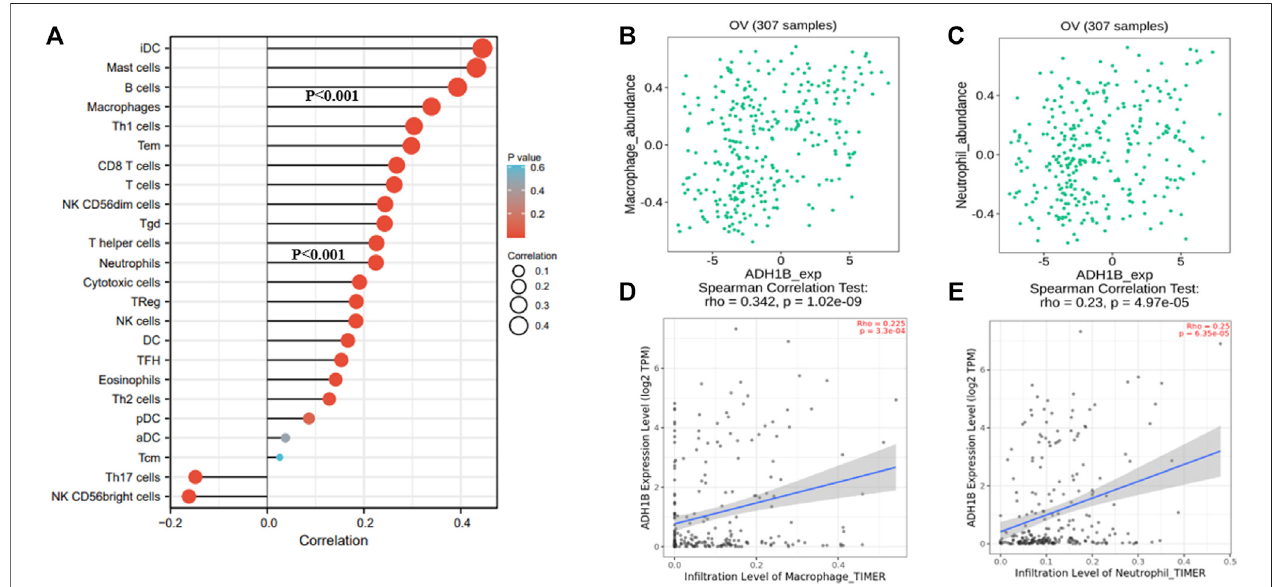
FIGURE 5 | The relationship between ADH1B and immune in fi ltration. (A) 24 kinds of immune-in fi ltrating cells related to ADH1B expression. (B – E) Scatter plots weredrawn through TIMER2.0 and TISIDBdatabase tovalidate the correlations betweenADH1Band immune-in fi ltratingcells, including macrophages and neutrophils.